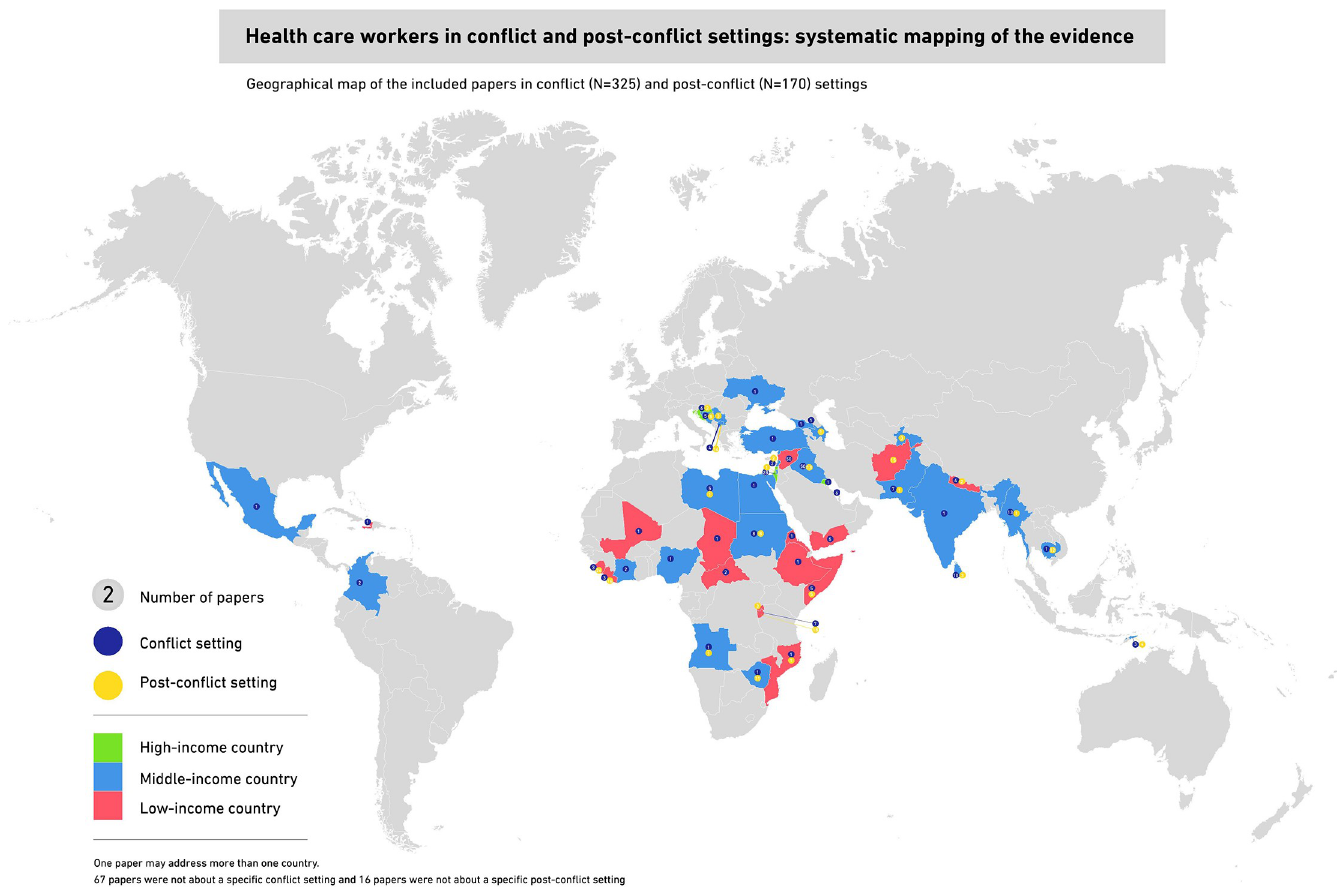
Fig 2. Geographical map of the included papers in conflict (N = 325) and post-conflict (N = 170)